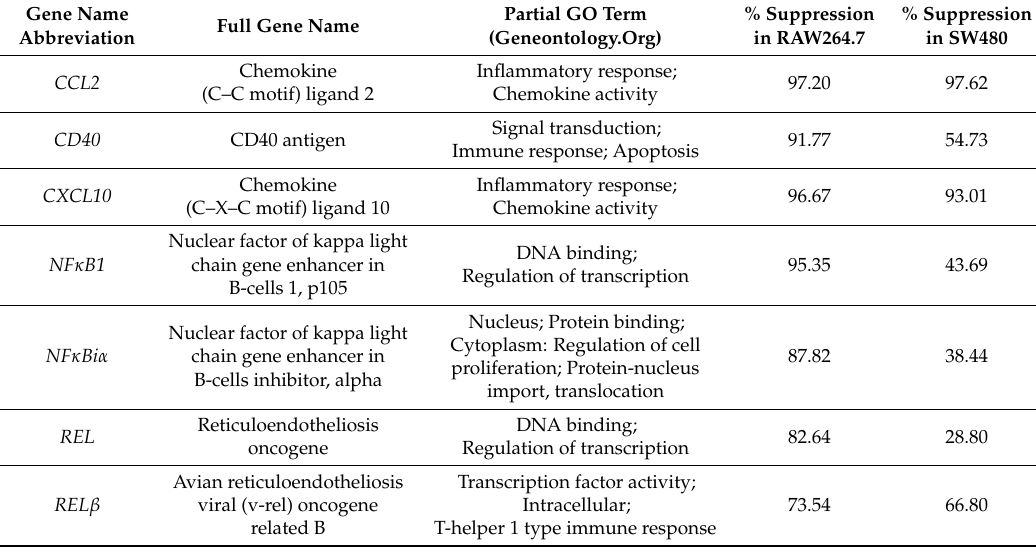
Table 2. Down-regulated inflammatory mediators in lipopolysaccharide induced macrophage and cancerous colon epithelial cells by 10 µ M